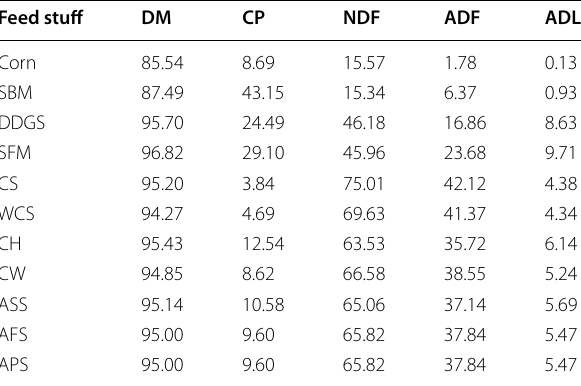
Table 1 The contents of DM, CP, NDF, ADF and ADL in raw